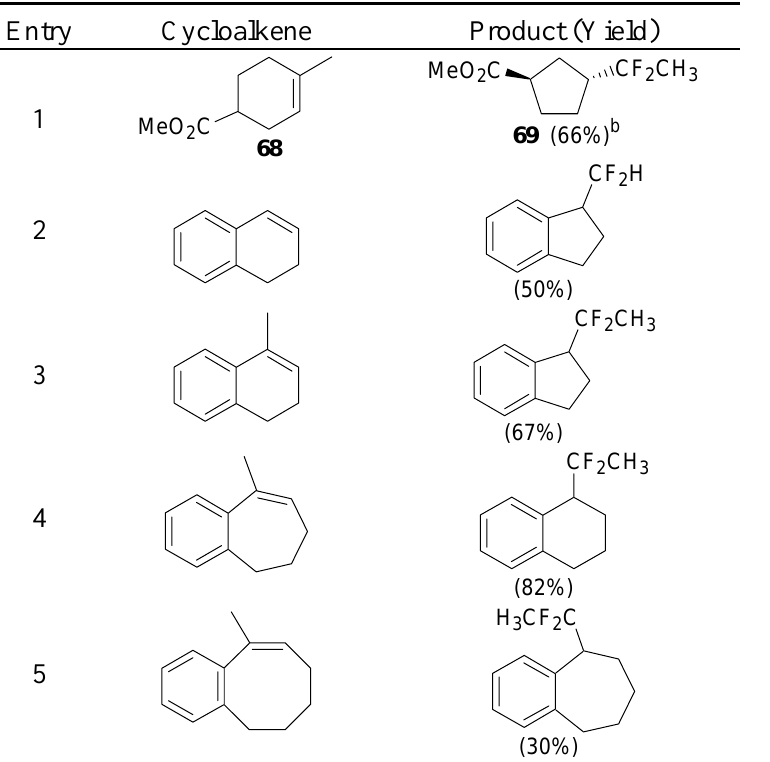
Table 4 . Ring Contraction of Cicloalkenes with 1.3 eq. p -Tol-IF